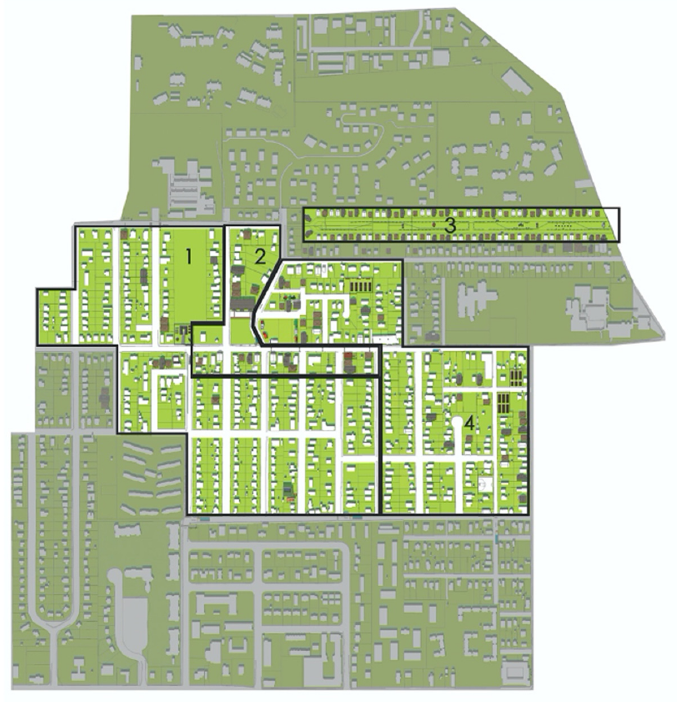
Figure 6. Urban design master plan.